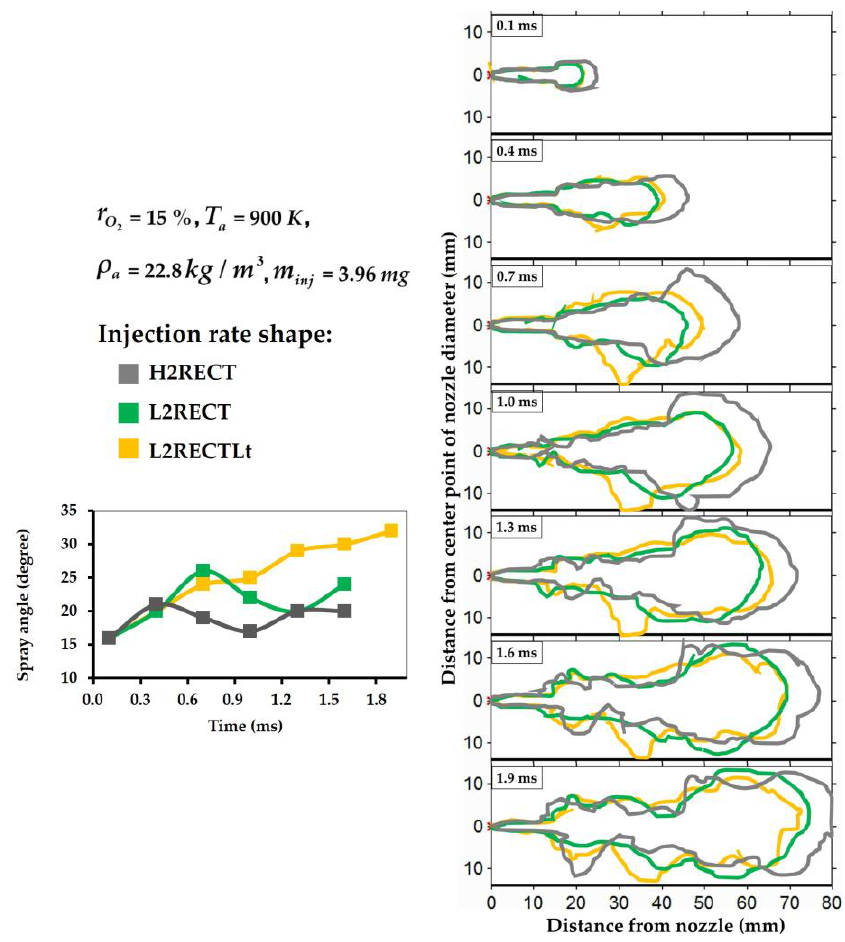
Figure 5. Variations of spray angle and spray boundaries in different multiple-injection